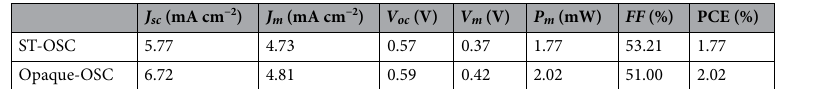
Table 2. The cell output parameters of (a) FTO/ZnO/P3HT:PCBM/MoO 3 /Ag (–/40/130/10/100 nm) opaque- OSC and, (b) FTO/ZnO/P3HT:PCBM/MoO 3 /Ag/MoO 3 (–/40/130/10/6/30 nm)